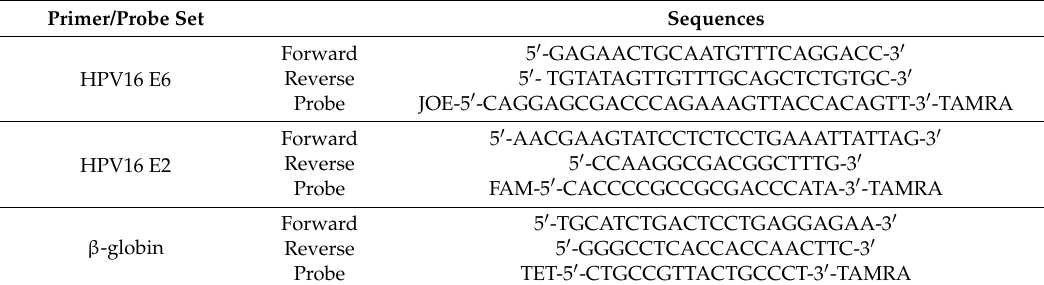
Table 1. Sequence-specific oligonucleotide primers and probes used for quantification of human papillomavirus (HPV) 16 DNA viral load (VL) by quantitative polymerase chain reaction